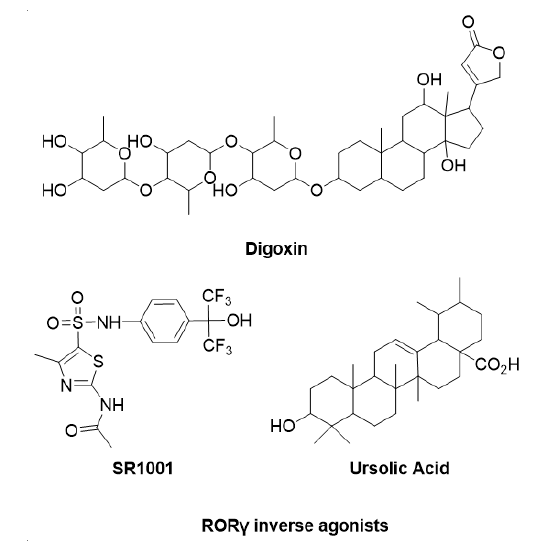
Figure 1 . RORγ inverse